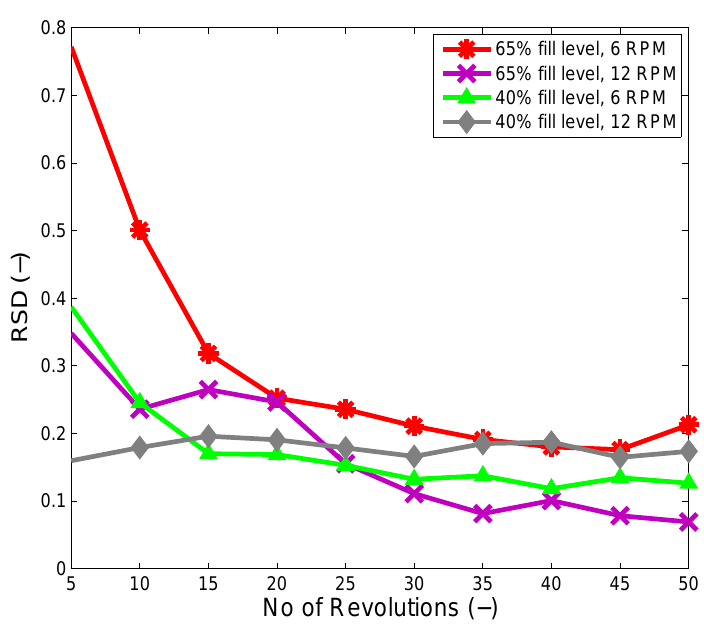
Figure 13. Variation of the RSD of API 1 with the change in the fill level and blender